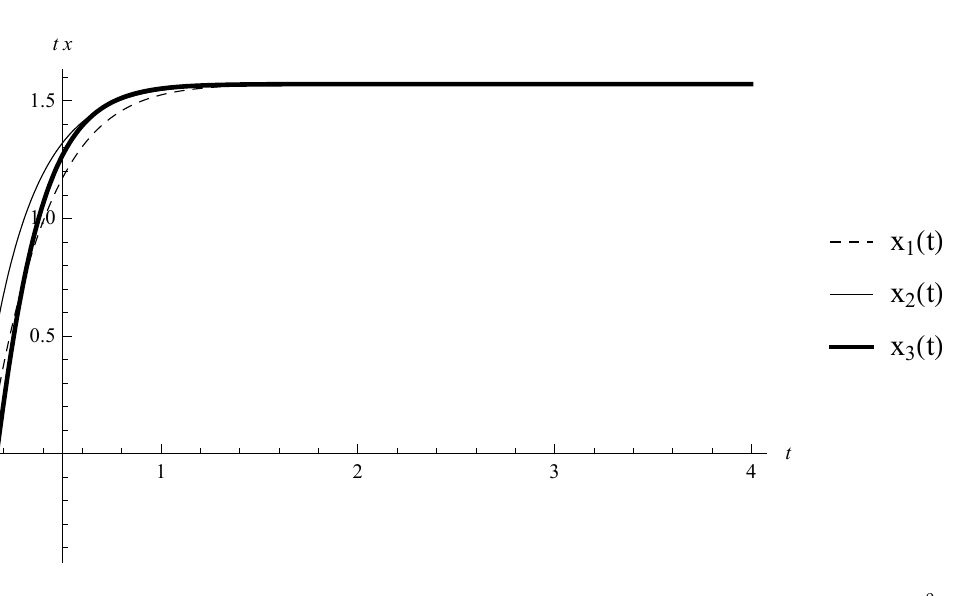
Figure 1. Example 1. Graph of the solution of the system ODE corresponding to (14) with x 0 = 1.4. 2, x 0 3